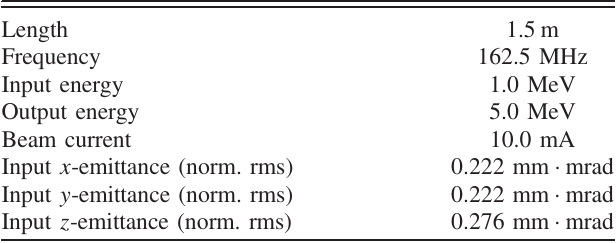
TABLE I. Linac design parameters for deuteron